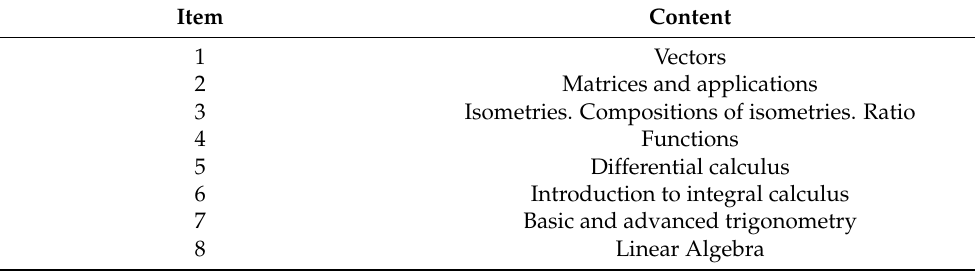
Table 2. Syllabus of the mathematics